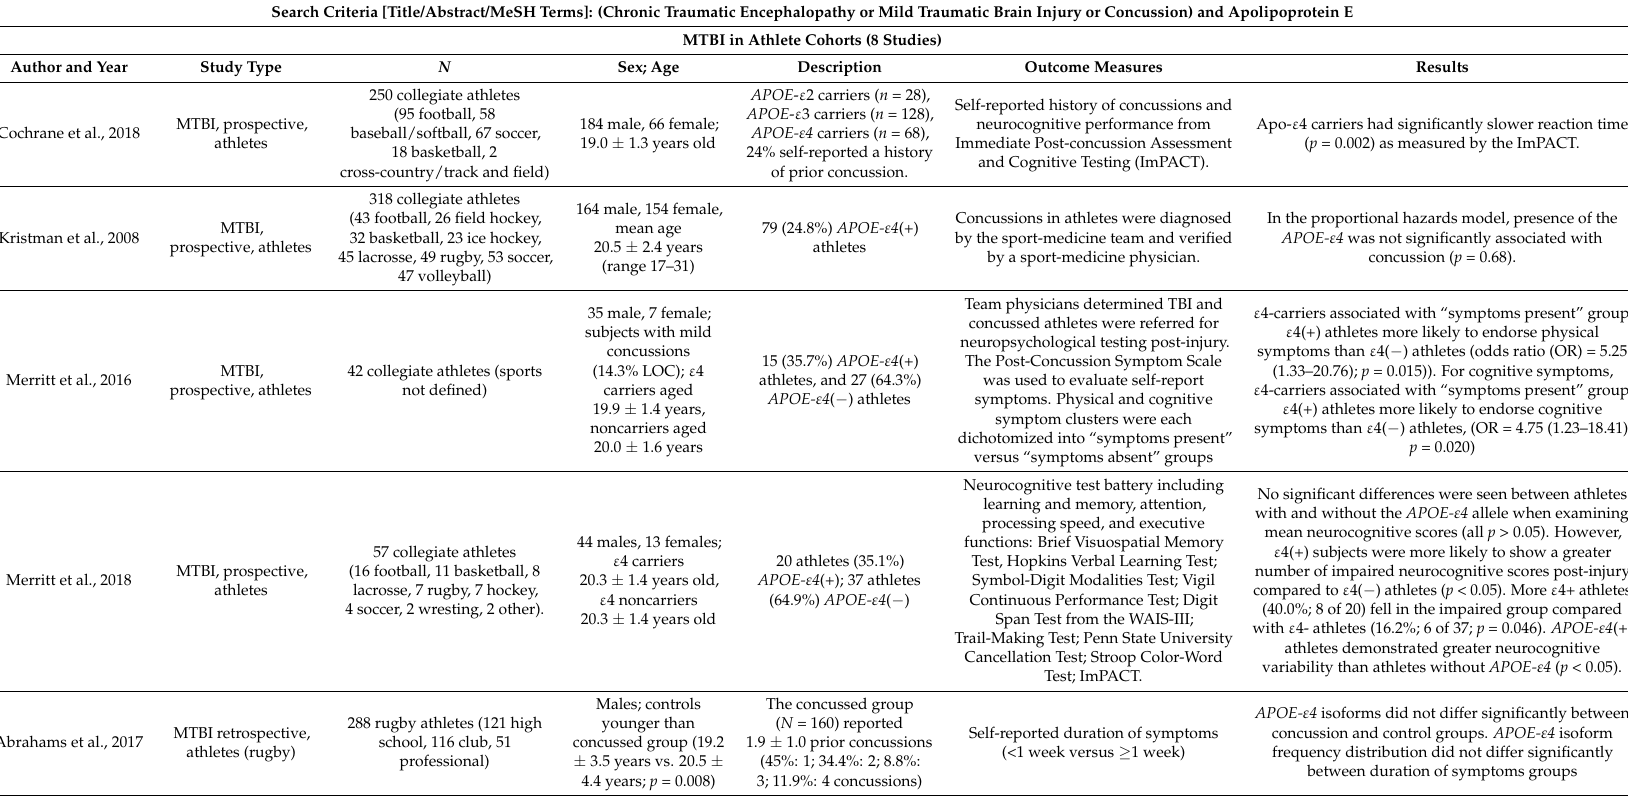
Table 1. Summary of included studies and findings for APOE allelic